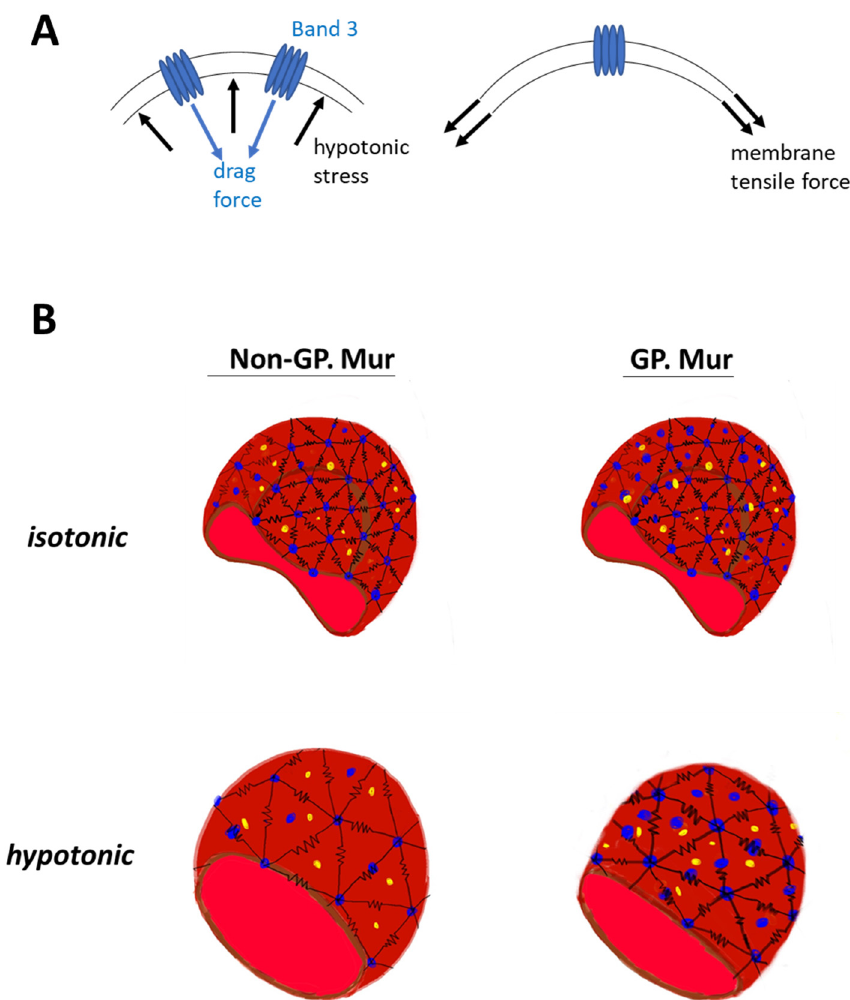
Figure 4. Working models: ( A ) A model illustrates how higher band 3 expression on the plasma membrane strengthens the membrane. Right: During the deformability or osmotic fragility tests, the cell membrane is extended laterally by the given membrane tension. The presence of band 3 disrupts the lateral membrane tension, as the materials that encounter the force change from lipid to protein. Left: Hypotonic stress that acts on the cell membrane and causes cell swelling is counteracted by a drag force. Because of the material differences between protein and lipid, band 3 (and its protein complexes and connected cytoskeletal network) endures a significant portion of the hypotonic stress and drag force. ( B ) GP.Mur and non-GP.Mur membrane mechanics are compared by the bead–spring model. Black springs are symbols for elastic spectrins, blue beads for tetrameric and dimeric band 3 complexes. Band 3–AQP1 complexes (blue and yellow beads) are either associated with the triangular cytoskeletal frame or independent from it (i.e., inside the triangles). Left: Non-GP.Mur normocyte. Right: GP.Mur+ normocyte. There are more band 3–AQP1 complexes on the GP.Mur+ membrane, which supports osmotic resistance to hypotonic stress.